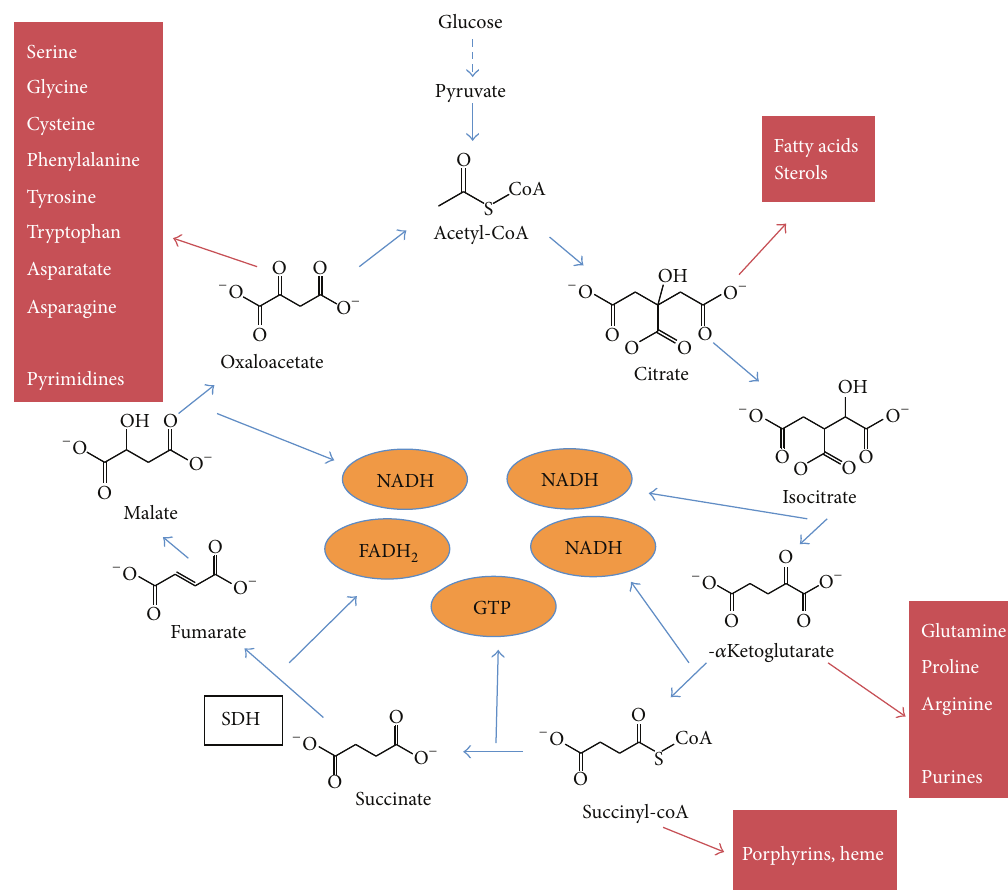
Figure 2: TCA cycle metabolites in anabolism. TCA cycle metabolites are precursors in a wide spectrum of biosynthetic pathways. In the boxes are final products of anabolism from the four TCA cycle metabolites indicated by red